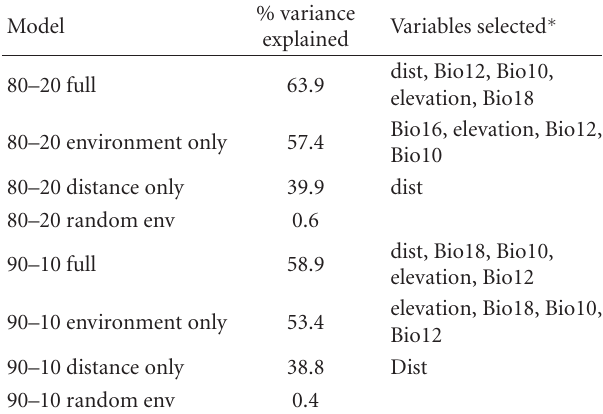
Table 4: Generalized dissimilarity modeling results. Shown are the percentages of the total variation observed and important predictor variables for “80–20” and “90–10” criteria for full models (using both geographic distance and environmental variables), models with environmental variables only, models with geographic distance only, and random models.